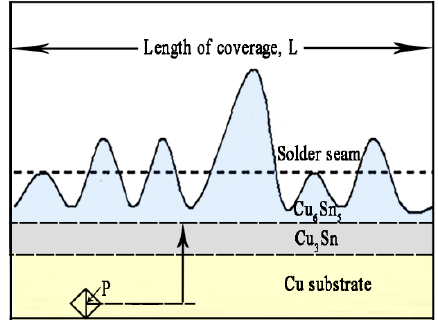
Figure 1. Schematic diagram of interfacial intermetallic compound.